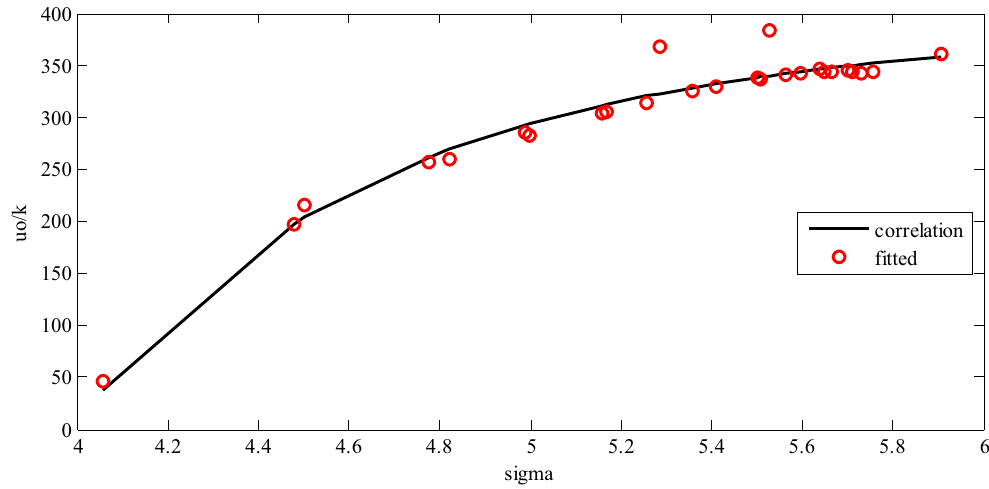
Figure 2. The fitted dispersion energies (symbol) versus correlated values from Eq. 17